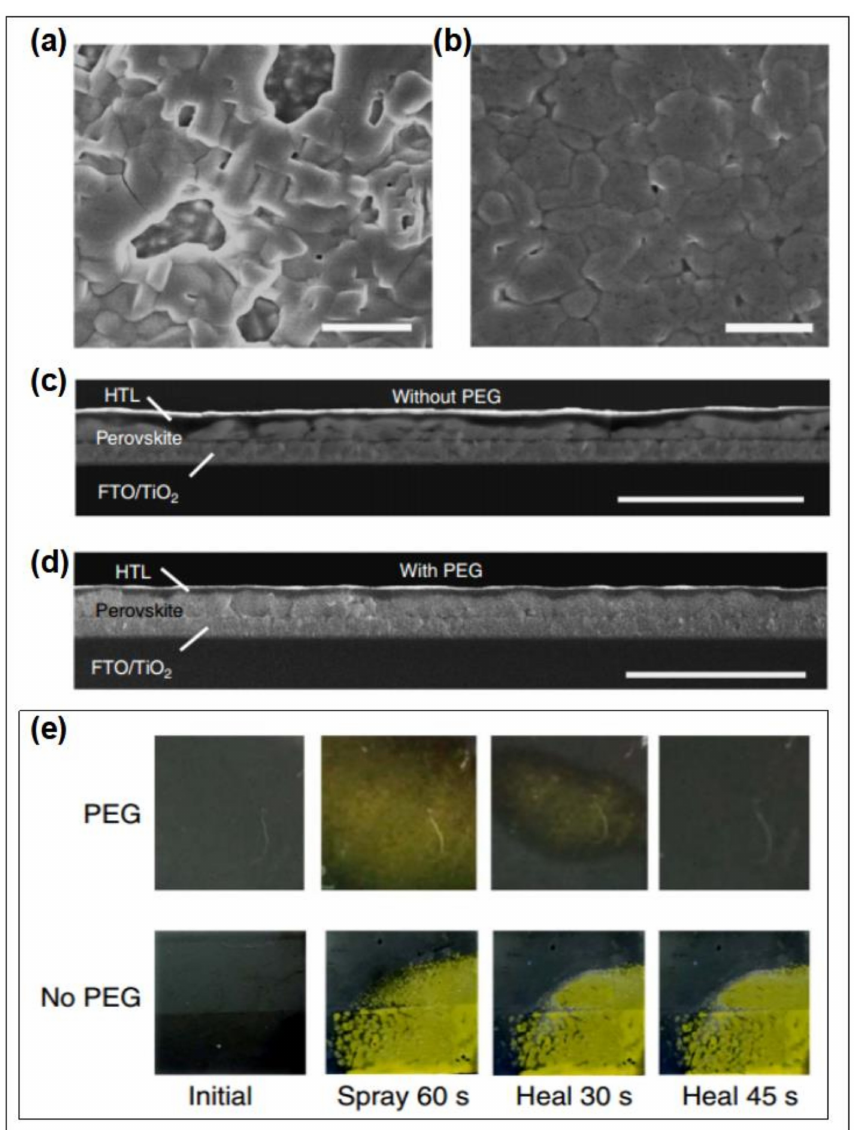
Figure 11. Comparisons of FESEM and corresponding cross-sectional FESEM images of perovskite films: ( a , c ) With PEG, and ( b , d ) without PEG, respectively. ( e ) Photographs of the color change of perovskite films with and without PEG after water-spraying for 60 s and kept in ambient air for 45 s (reproduced from Reference [171] with permission, copyright Nature Publishing Group,